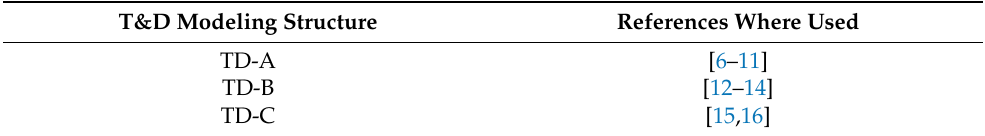
Figure 2. Three integrated T&D modeling structures for steady-state analysis used in the literature. TD-A represents a single consolidated model, whereas TD-B and TD-C model transmission and distribution separately, which may be connected using coupling circuits or solved iteratively. Table 1. References that used the three integrated transmission-and-distribution (T&D) modeling structures for steady-state analysis.